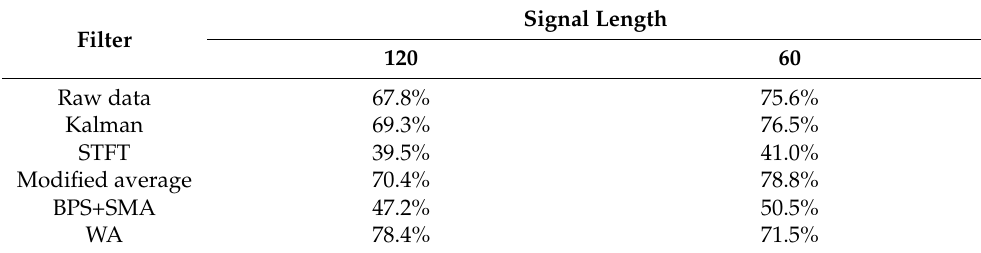
Figure 10. PPG signals for a distance 0.8 mm: ( a ) Raw data; ( b ) Kalman filter; ( c ) STFT; ( d ) Modified average filter; ( e ) BPS+SMA filter; ( f ) WA filter. Table 3. Accuracy of LeNet-5 for filtered PPG data.